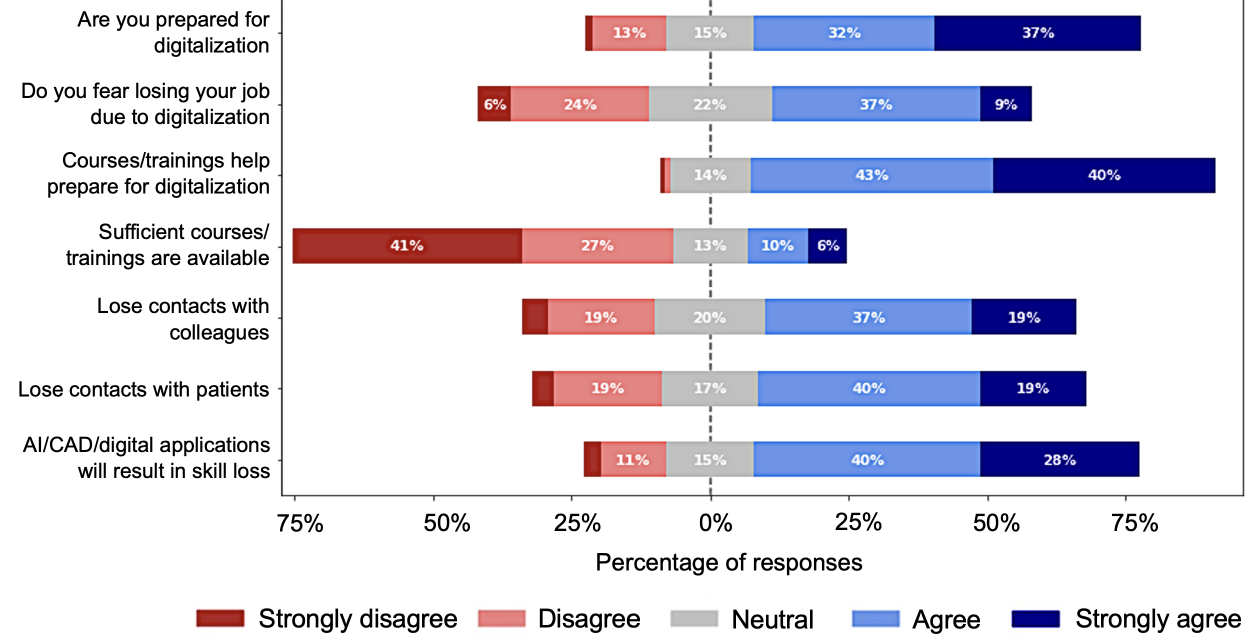
Figure 4. Impressions of professionals on different aspects of